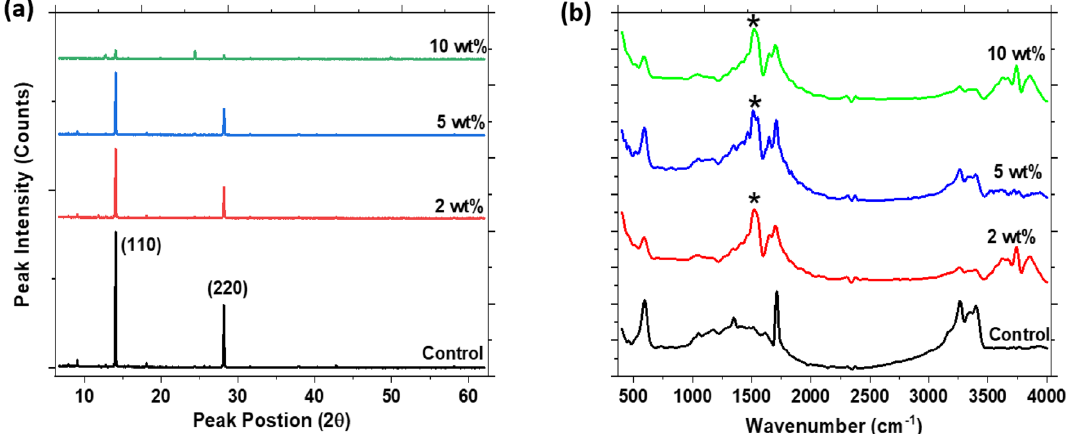
Figure 3. ( a ) XRD patterns, and ( b ) FTIR spectra of the perovskite films at different weight proportions of